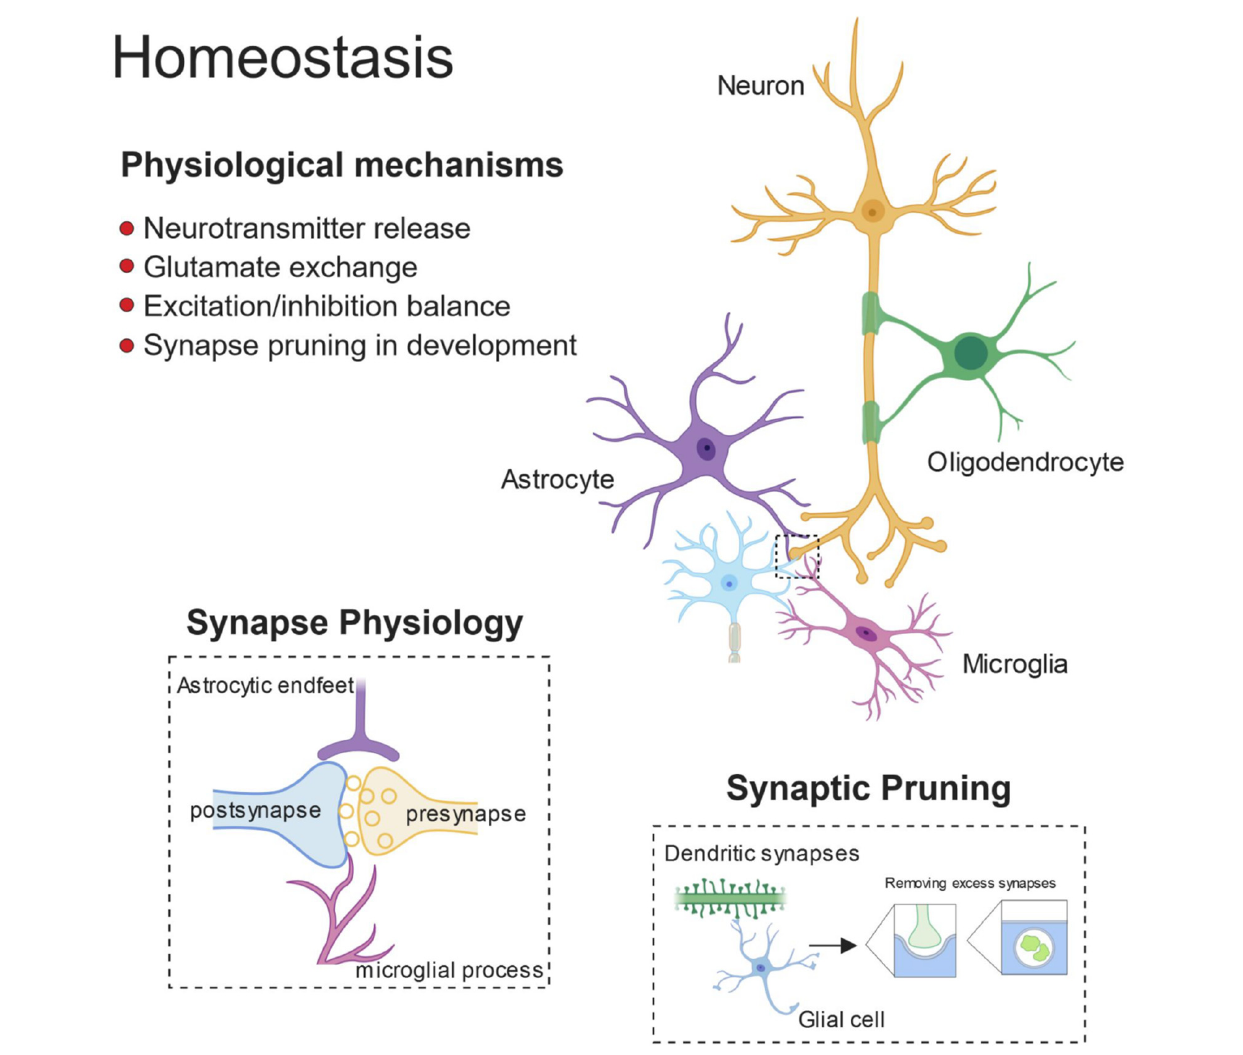
FIGURE 1 | Glial control of synaptic homoeostasis. Synapses exists as tri- or even quad-partite structures with glial processes in direct contact with neuronal components. Glia play important roles in regulating efficient neurotransmitter release and clearance, as well as providing trophic factors to ensure healthy function. Furthermore, during development glia prune away excess synapses and by doing so, fine-tune the excitatory/inhibitory balance within developing neuronal networks.